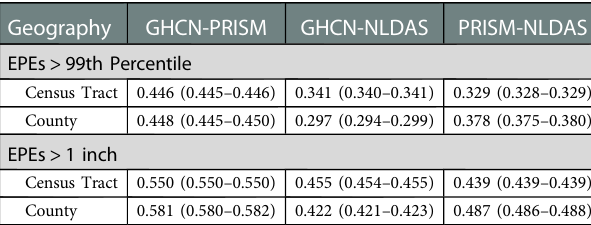
TABLE 1 Agreement in EPE (>99th percentile) identi fi cation, 1991 –